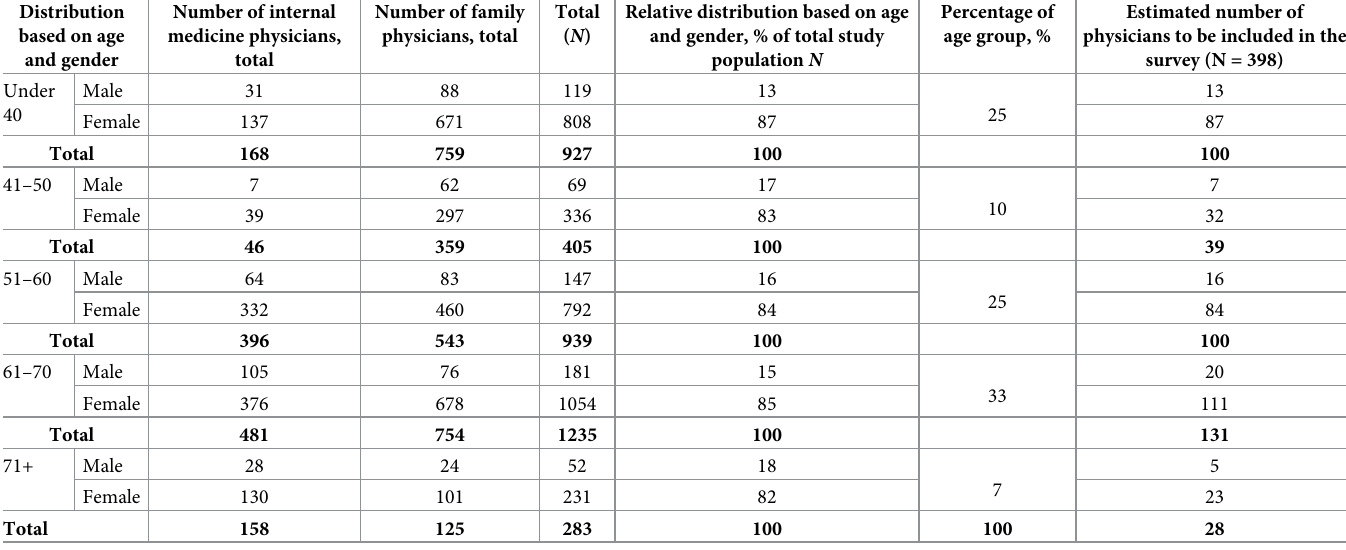
Table 2. The distribution of family and internal medicine physicians in the study population based on age and